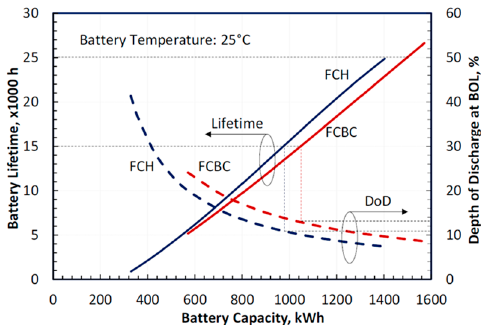
Figure 5. The trade-off between battery capacity and battery lifetime in the FCH and FCBC config- urations. A smaller battery has a shorter lifetime and requires one or more replacements over 25,000 h.